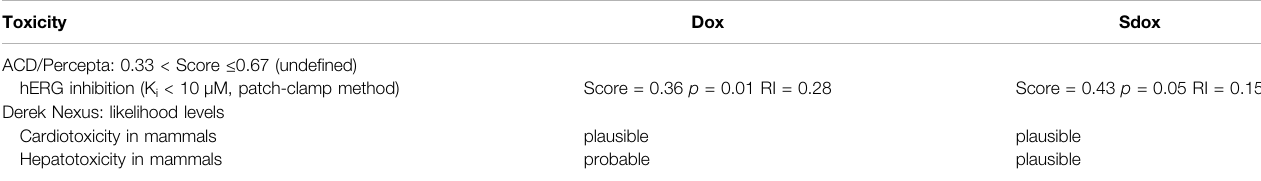
TABLE 3 | Toxicity predictions of Dox and Sdox.